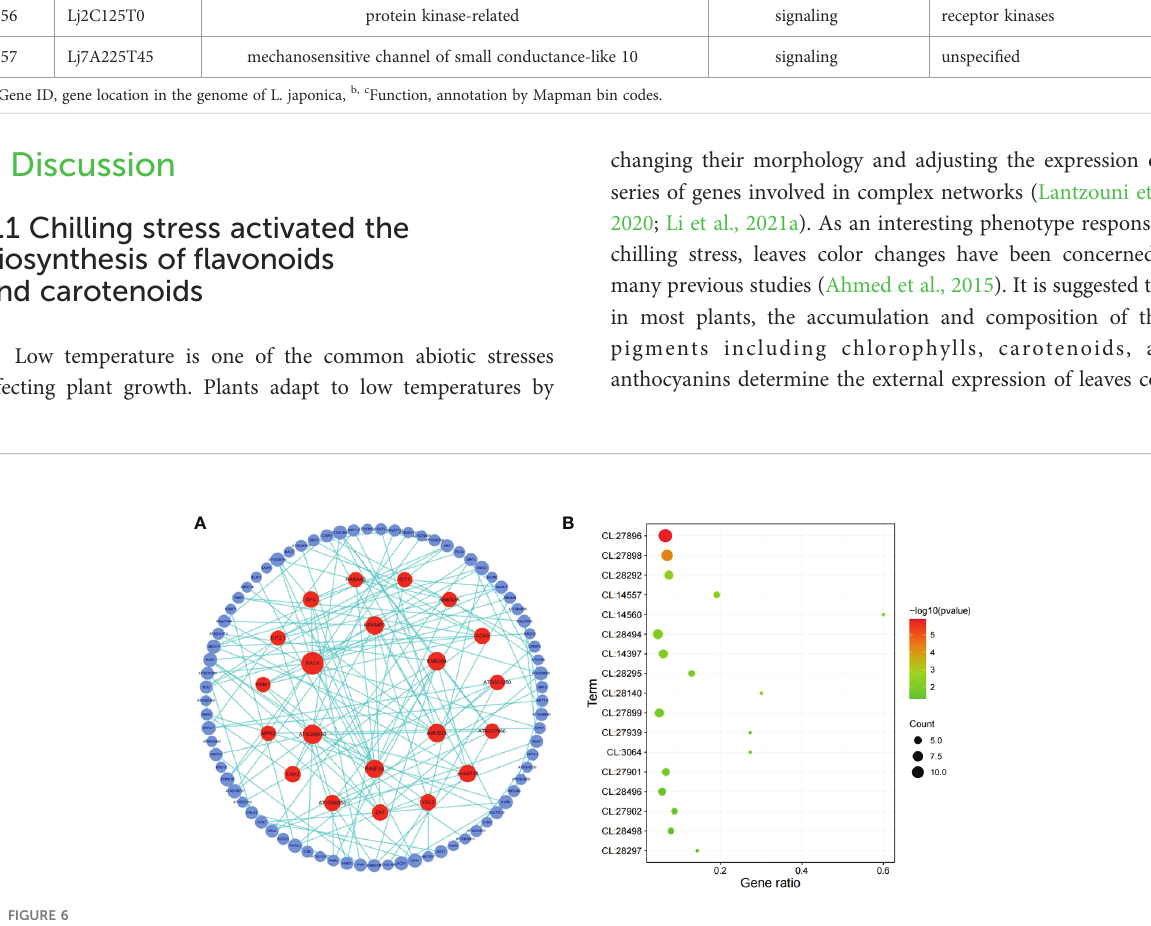
FIGURE 6 PPI analysis of DEGs related to signaling and transport in C10-C11. (A) Network of protein-protein interaction (PPI). The circles represent the proteins and the lines represent the interactions of two proteins. The size and color of circles indicate the degree value represented by the number of the interacting proteins. The circles with a high degree value (above 4) which was represented by the number of interacting proteins were pained by red color. (B) Bubble map of functional enrichment of genes. CL:27896, Mixed, incl. transition metal ion transport, and heavy metal-associated domain superfamily; CL:27898, Mixed, incl. transition metal ion transport, and heavy metal-associated domain superfamily; CL:28292, Calcium transport, and potassium ion transport; CL:14557, Mixed, incl. citrate transporter, and tlc atp/adp transporter; CL:14560, Citrate transporter, and plasma membrane pyruvate transport; CL:28494, Mixed, incl. anion transmembrane transporter activity, and lateral organ boundaries, lob; CL:14397, Mixed, incl. chloroplast membrane, and mitochondrial carrier protein; CL:28295, Sodium/calcium exchanger protein, and Cation transporting ATPase, C-terminus; CL:28140, Mixed, incl. abc transporter, cbio/ecfa subunit, and ferric-chelate reductase activity; CL:27899, Mixed, incl. transition metal ion transmembrane transporter activity, and heavy metal-associated domain superfamily; CL:27939, Mixed, incl. iron transport, and nickel transport; CL:3064, Mixed, incl. gtp-binding protein enga, and endoplasmic reticulum vesicle transporter; CL:27901, Mixed, incl. zinc ion transmembrane transport, and iron ion homeostasis; CL:28496, Mixed, incl. nitrate assimilation, and malate transport; CL:27902, Mixed, incl. iron ion homeostasis, and nicotianamine synthase; CL:28498, Mixed, incl. response to nitrate, and molybdenum cofactor biosynthesis; CL:28297, Sodium/calcium exchanger protein, and Cation transporting ATPase,